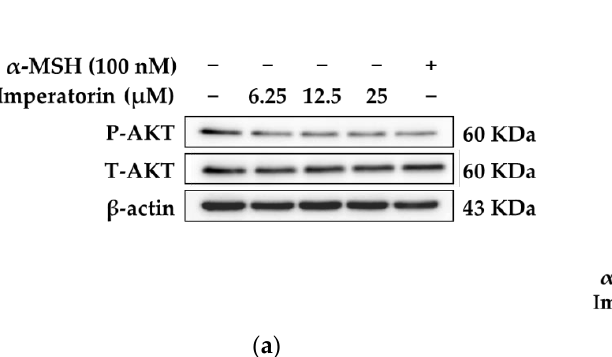
Figure 7. The effects on the protein expression of AKT in B16F10 melanoma cells when the cells were treated with imperatorin (25, 12.5 and 6.25 μM) for 4 h: ( a ) Western blotting results; ( b ) protein levels of MITF. β -Actin was used as a loading control. The results are presented as the mean ± SD from three independent measurements using ImageJ software. *** p < 0.001 vs. the untreated control group.